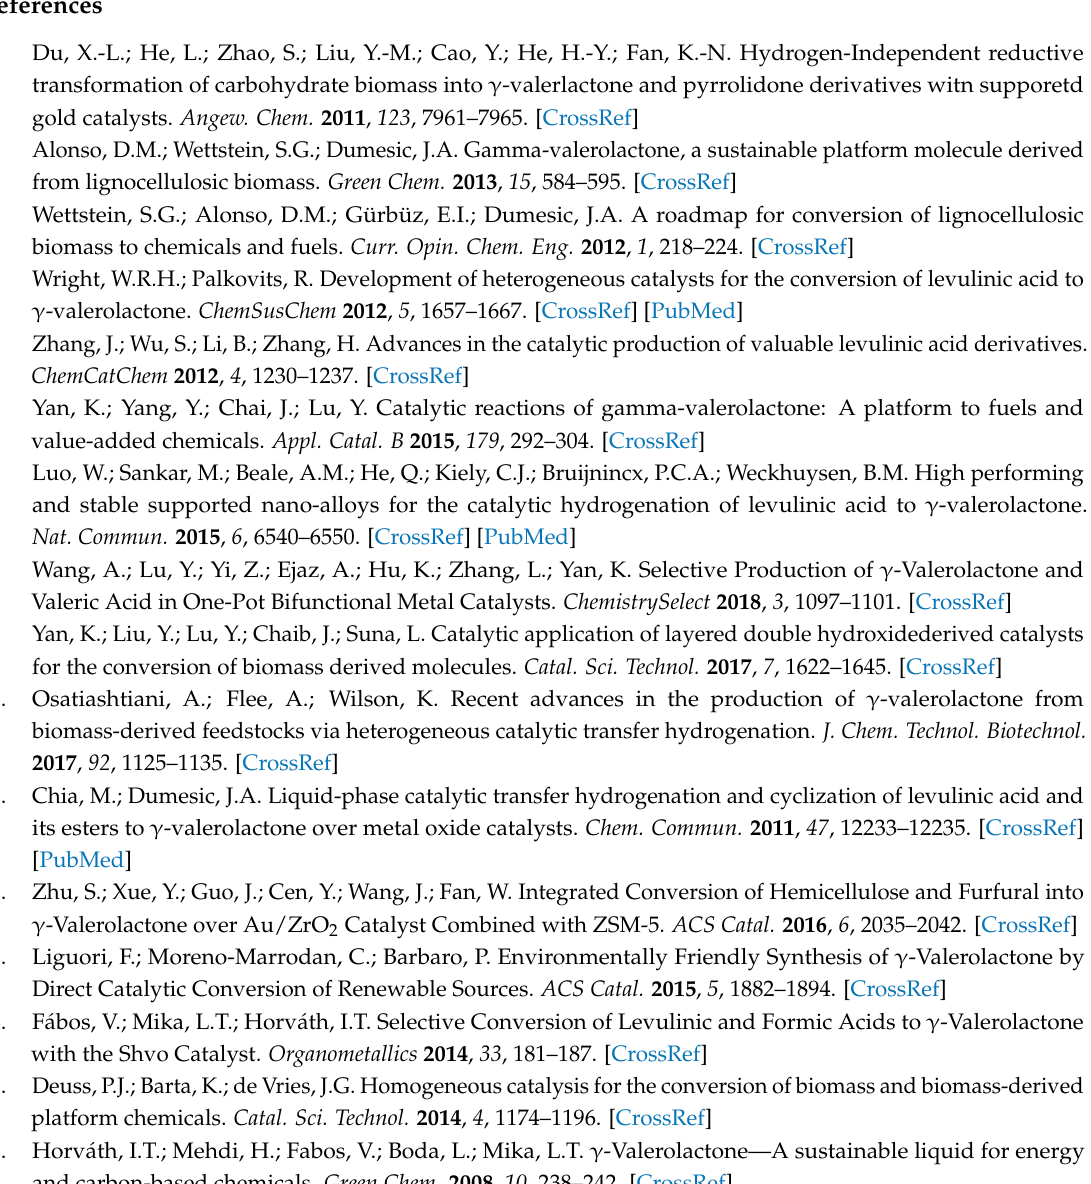
s1, Figure S1: Pore size distribution and N 2 adsorption-desorption isotherms for samples of 0.6 wt % Au catalyst supported on Ce x Zr 1 − x O 2 , Figure S2: XP spectra of the Ce (3d) of ( a ) Ce x Zr 1 − x O 2 and ( b ) 0.6 wt % Au/Ce x Zr 1 − x O 2 , Figure S3: XP spectra of 2 wt % Au/Ce 0.4 Zr 0.6 O 2 catalyst: ( a ) before reaction; ( b ) after five runs, Table S1: BET analysis and H 2 consumption from TPR of 0.6 wt % Au/Ce x Zr 1 − x O 2 , Table S2: The relative concentration of surface cerium species on different supports and catalysts, Table S3: The relative concentration of surface O1s on different supports and